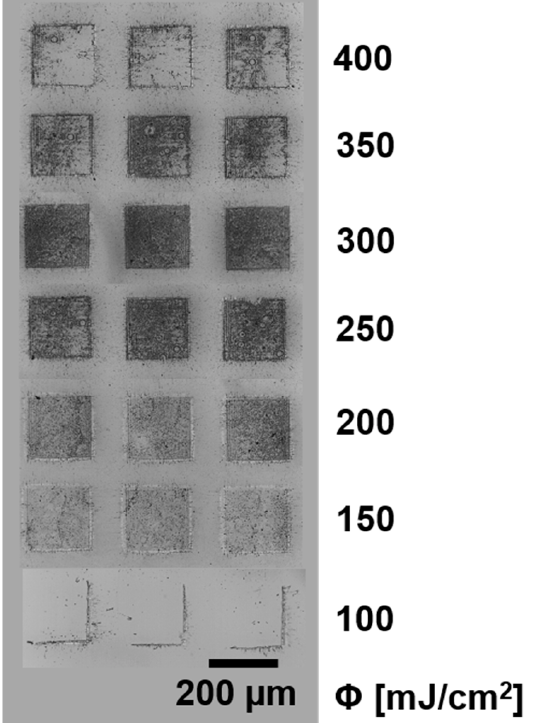
Figure 3. SWCNT@SnO 2 microarray, transferred by LIFT by keeping the donor and receiver sub- strates in contact.